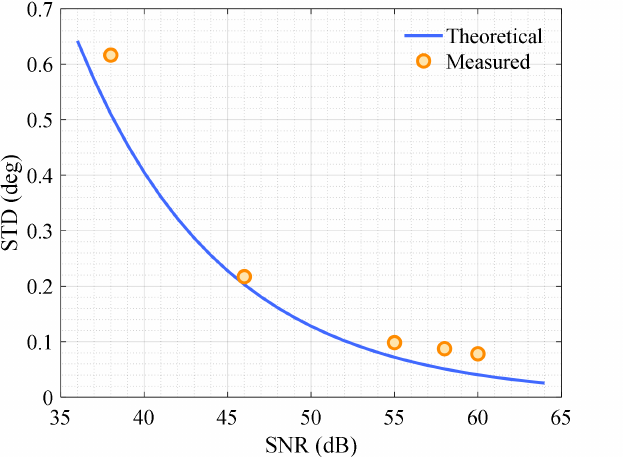
Figure 7. STD of residual phase error versus SNR of synchronization